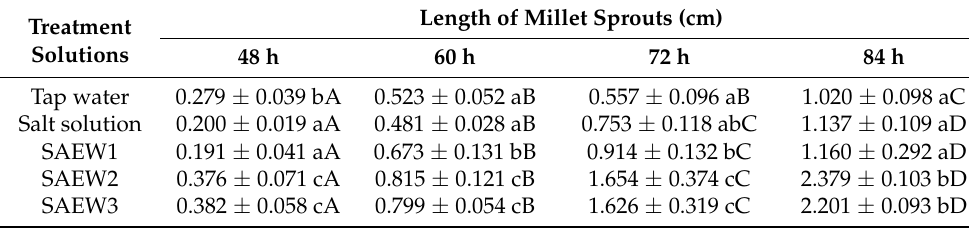
Table 2. Effects of different germination treatments on the length of foxtail millet sprouts 1 . Treatment